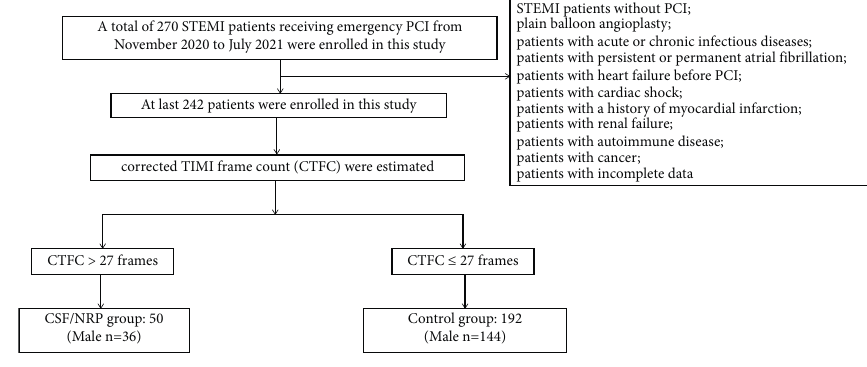
Figure 1: Study flow diagram. Table1: Baseline characteristics of study population, mean ± SD or n